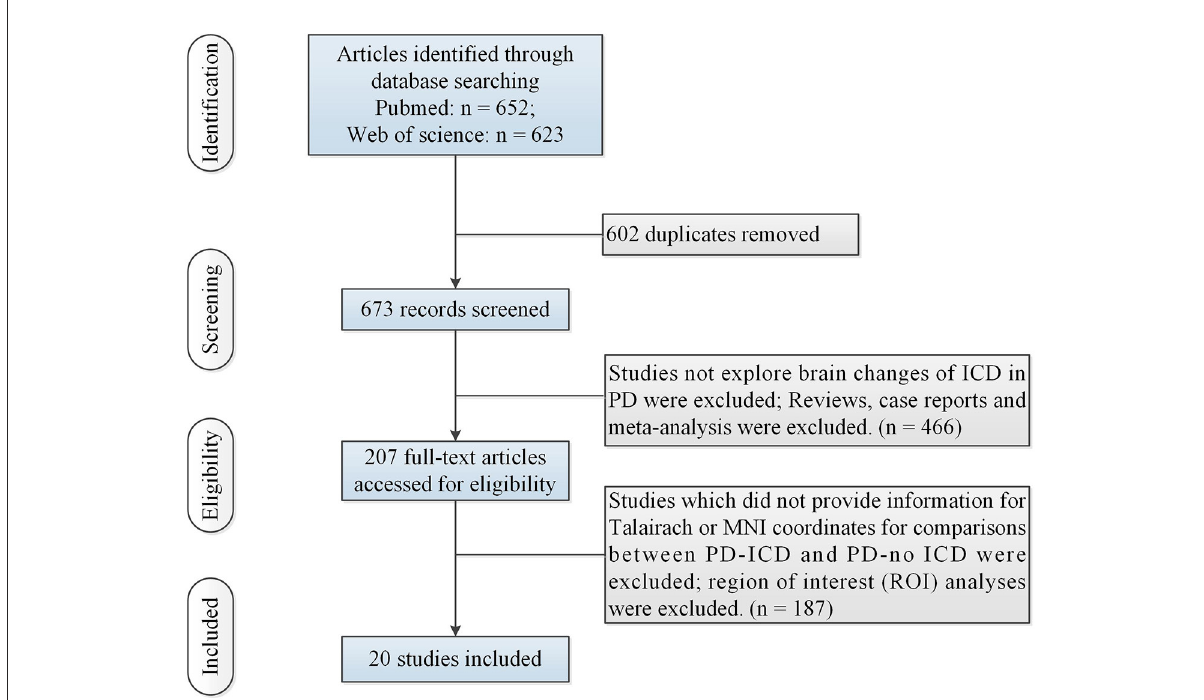
FIGURE1 Flow of information through the different phases of the ALE study. ALE, activation likelihood estimation; ICD, impulse control disorder; MNI, Montreal Neurologic Institute; PD, Parkinson’s